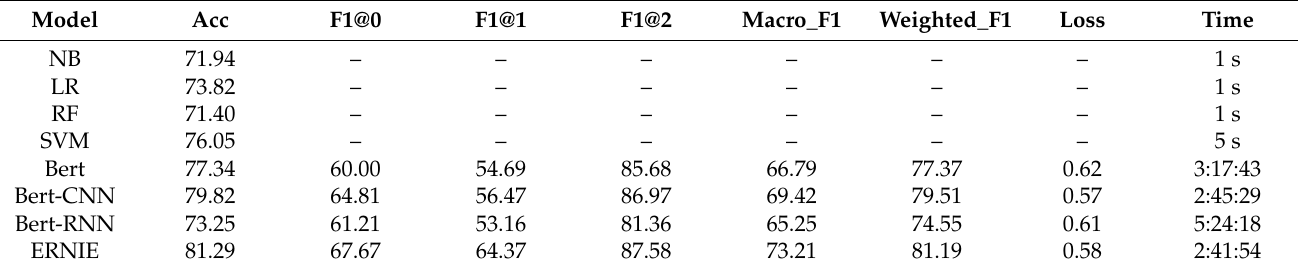
Table 3. Comparative performance of various classification models.